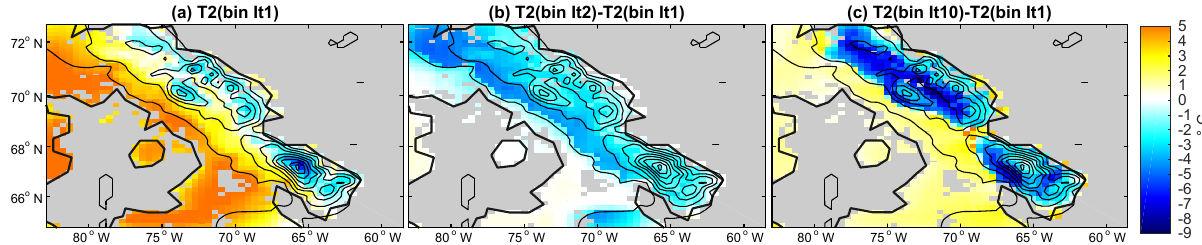
Figure 4. The summer 2m temperature in select asynchronous coupling iterations: (a) the temperature in the Iteration 1 WRF run. Dif- ferences in temperature between Iteration 1 and the (b) second and (c) last iterations. Note that “bin” refers to the mass balance binning procedure used in each iteration.